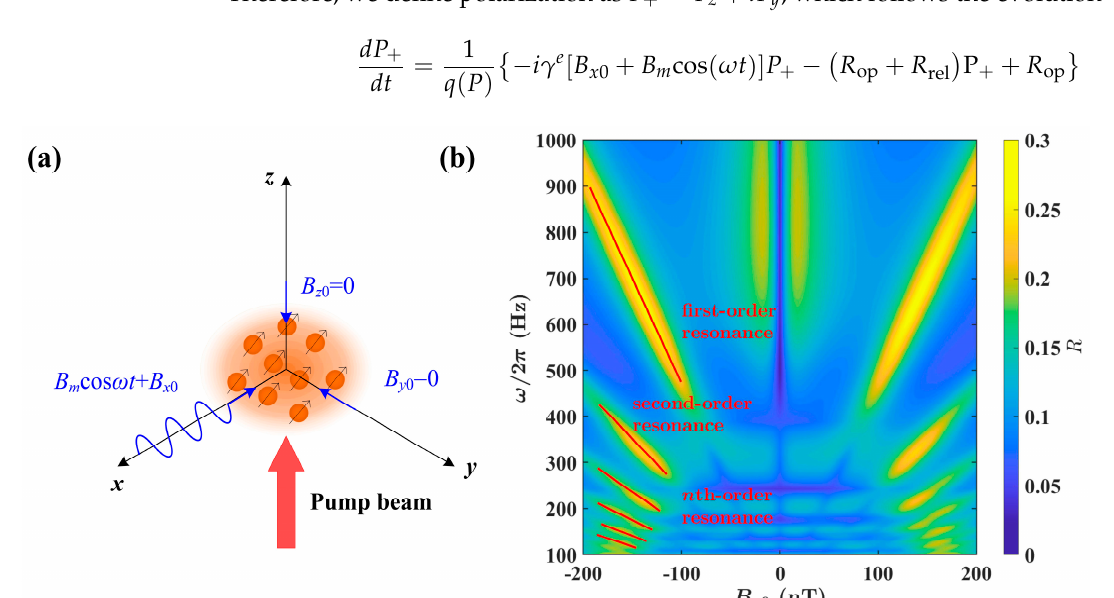
Figure 1. ( a ) Schematic of our single-beam SERF magnetometer with the modulated magnetic field along the x -axis. ( b ) Simulation results of the magnetometer response R under different ω /2 π and B x 0 , with B m = 200